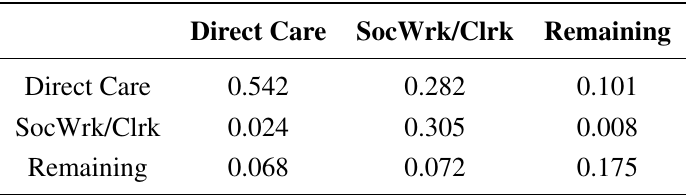
Table 4. The decrease in the number of individuals infected of the row group from vaccinating one additional individual from the column